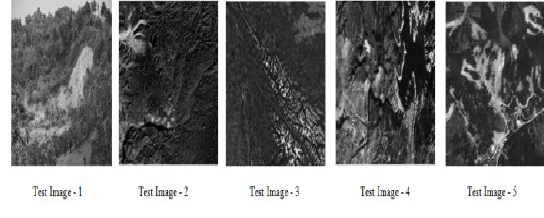
�𝑀𝑀𝐴𝐴𝐴𝐴 𝑖𝑖 𝑃𝑃𝑃𝑃𝑃𝑃𝑃𝑃 = 20log 10 √𝑀𝑀𝑃𝑃𝑀𝑀� (3) where , MSE is mean square error and said to be the average squared difference between the estimated values or the average of square of errors and is given by